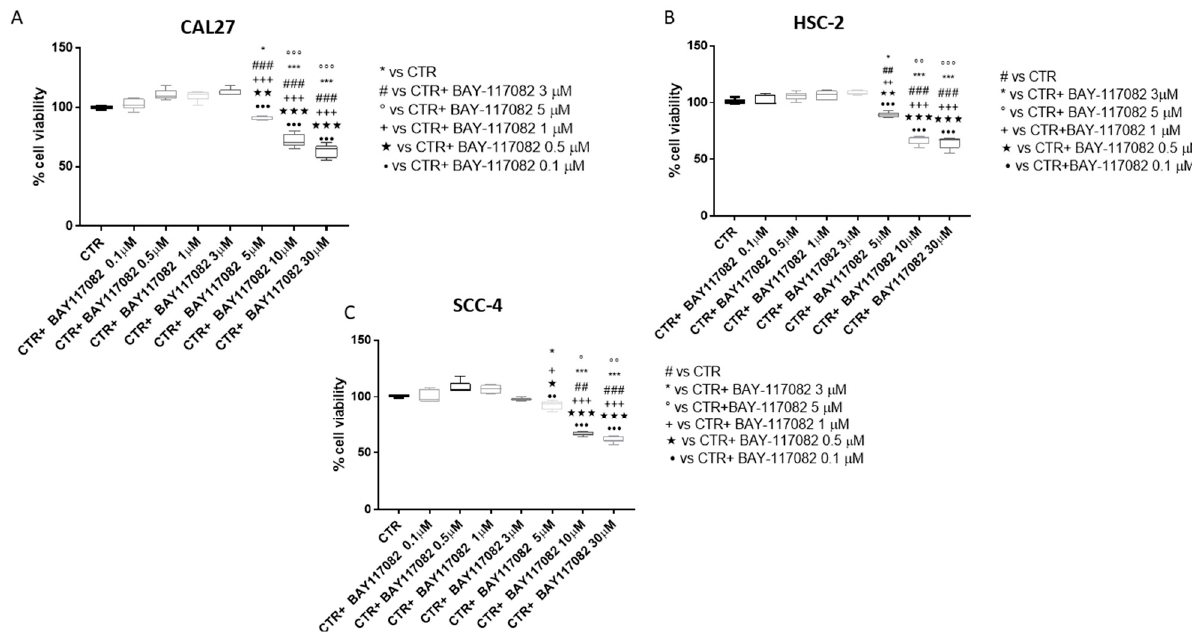
Figure 1. Effect of BAY-117082 on CAL27, HSC-2 and SCC-4 cell viability. MTT results demonstrate that BAY-117082 at higher concentrations significantly reduced CAL27, HSC-2, and SCC-4 cell viability. ( A ) * p < 0.05 vs. CTR; *** p < 0.001 vs. CTR; ### p < 0.001 vs. CTR + BAY-117082 3 µM; °°° p < 0.001 vs. CTR + BAY-117082 5 µM; +++ p < 0.001 vs. CTR + BAY-117082 1 µM; ••• p < 0.001 vs. CTR + BAY-117082 0.1 µM; ★★ p < 0.01, ★★★ p < 0.001 vs. CTR + BAY-117082 0.5 µM; ( B ) ## p < 0.01 , ### p < 0.001 vs. CTR; * p < 0.05, *** p < 0.001 vs. CTR + BAY-117082 3 µM; °° p < 0.01, °°° p < 0.001 vs. CTR + BAY-117082 5 µM; ++ p < 0.01, +++ p < 0.001 vs. CTR + BAY-117082 1 µM; ★★ p < 0.01, ★★★ p < 0.001 vs. CTR + BAY-117082 0.5 µM; ••• p < 0.001 vs. CTR + BAY-117082 0.1 µM; . ( C ) ## p < 0.01, ### p < 0.001 vs. CTR; * p < 0.05, *** p < 0.001 vs. CTR + BAY-117082 3 µM; ° p < 0.05, °° p < 0.01 vs. CTR + BAY-117082 5 µM; + p < 0.05 +++ p < 0.001 vs. CTR + BAY-117082 1 µM; ★ p < 0.05, ★★★ p < 0.001 vs. CTR+BAY-117082 0.5 µM; •• p < 0.01, ••• p < 0.001 vs. CTR + BAY-117082 0.1 µM.